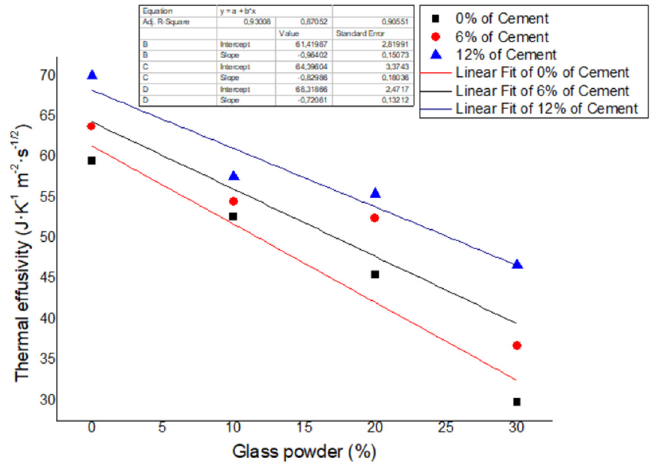
Figure 12. Variation of the thermal effusivity of the measured mortars in the dry state as a function of the glass powder content.